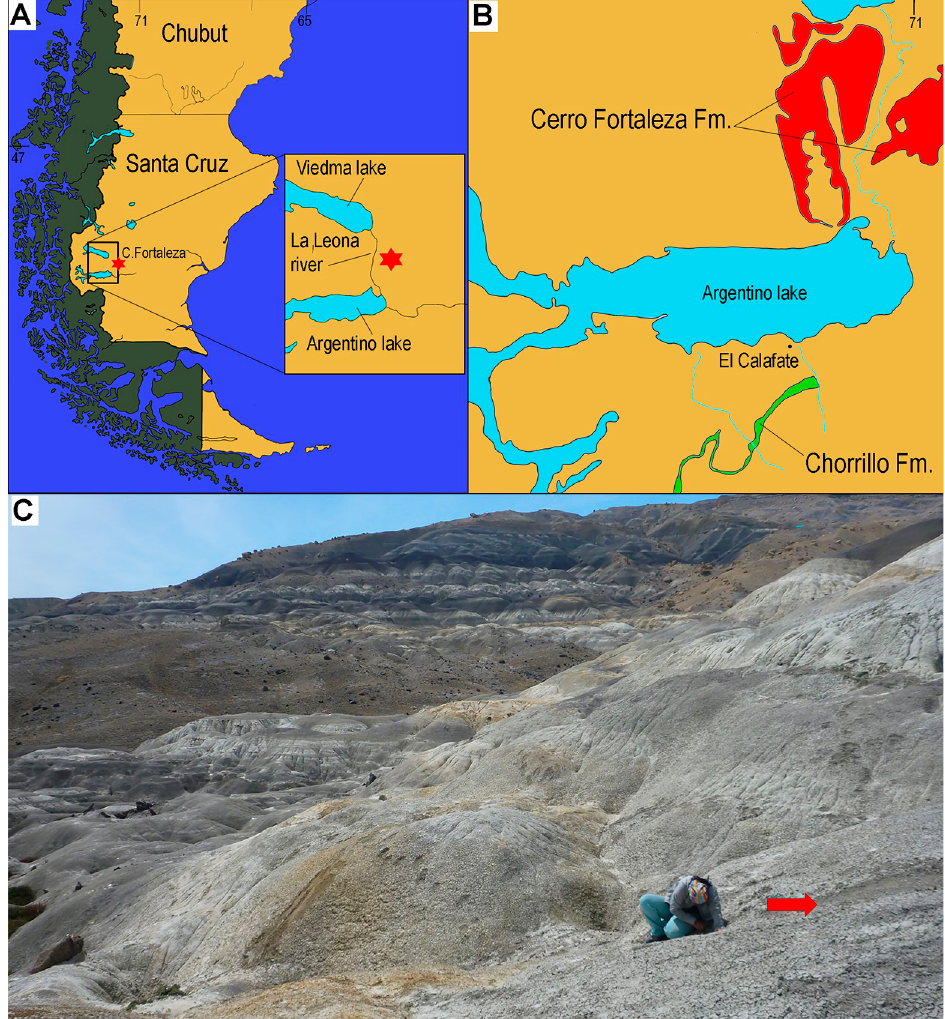
Fig 1. Location map showing the provenance of the teeth and osteoderms. Southern South America, with the Cerro Fortaleza type-locality indicated by the star (A). Region between Viedma and Argentino lakes showing the Cerro Fortaleza Formation (red color) outcropping at both sides of La Leona river. The Chorrillo Formation is indicated in green (B). Photography of the site, the red arrow indicates the level with teeth and osteoderms (C). B is based on